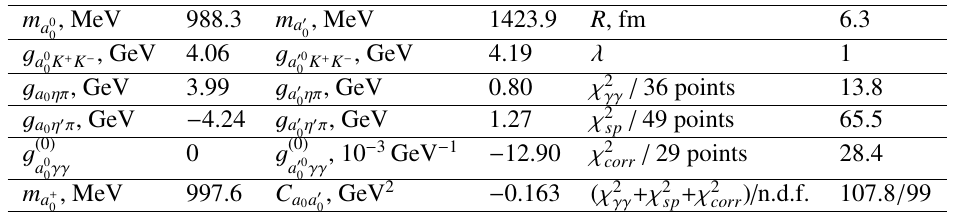
Table 1. Properties of the resonances and the description